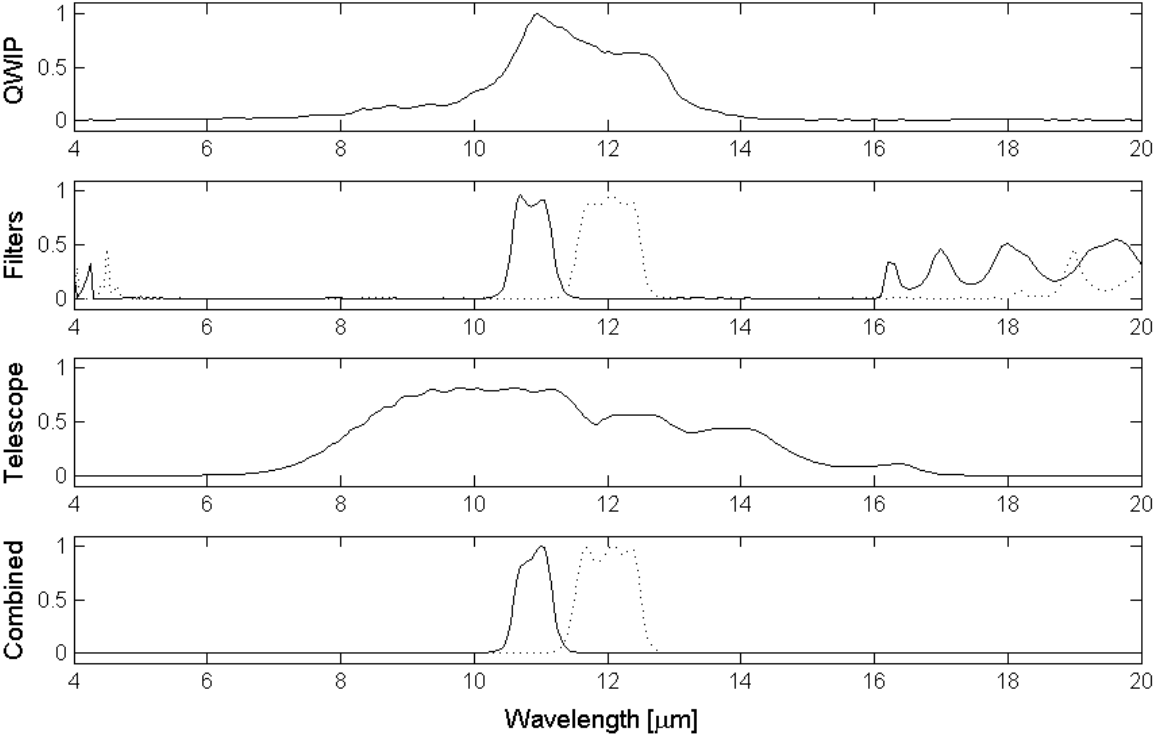
Spectral responses of the TIRS system. From top to bottom: average peak-normalized response of the Quantum Well Infrared Photodetectors (QWIPs); average peak-normalized transmission of the two spectral interference filters; transmission of the telescope lenses; combined average peak-normalized response of each TIRS spectral